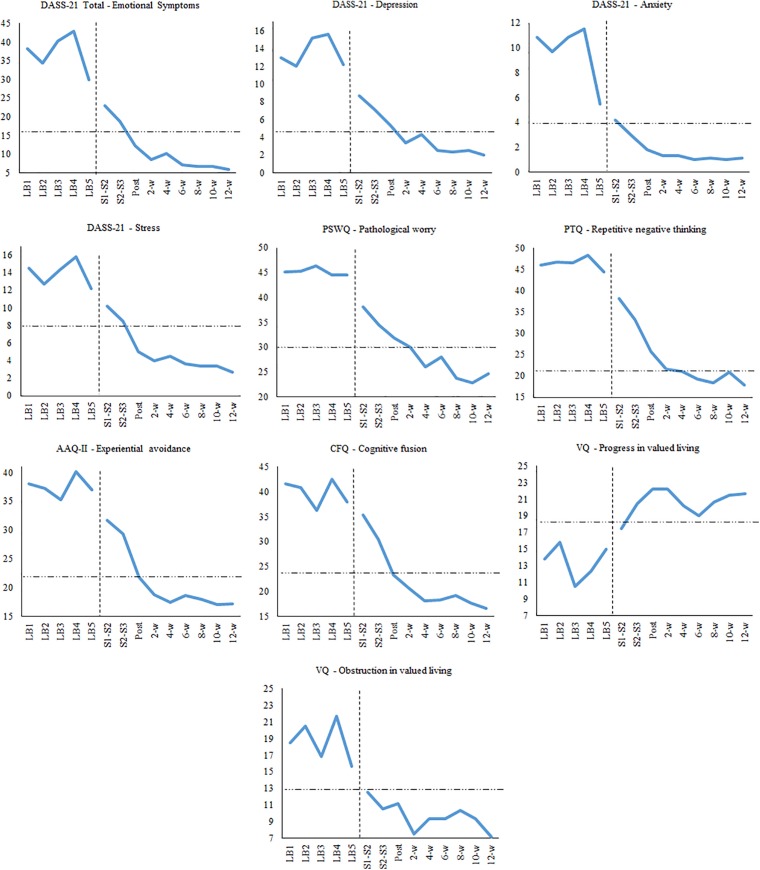
Mean scores on outcome and process measures across the study.